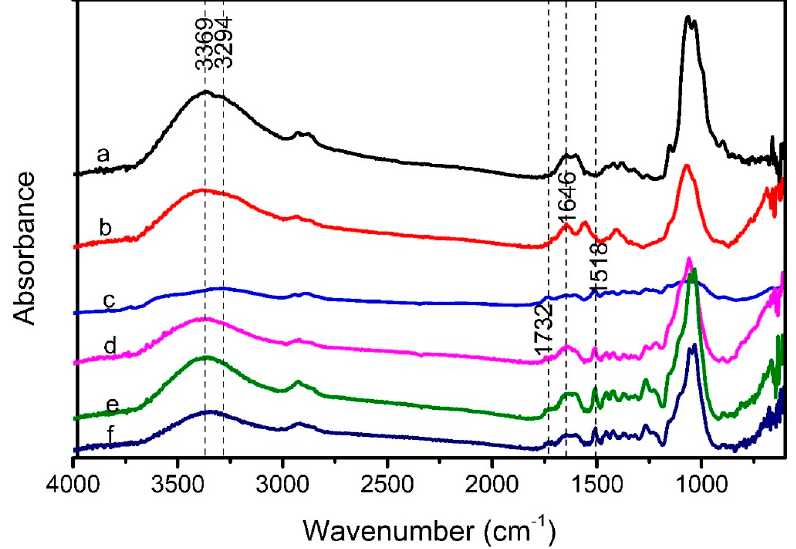
Figure 4. FTIR spectra of CS ( a ); GC ( b ); GC/MWCNT ( c ); LC composite ( d ); LC/GC composite ( e ); LC/GC/MWCNT composite ( f